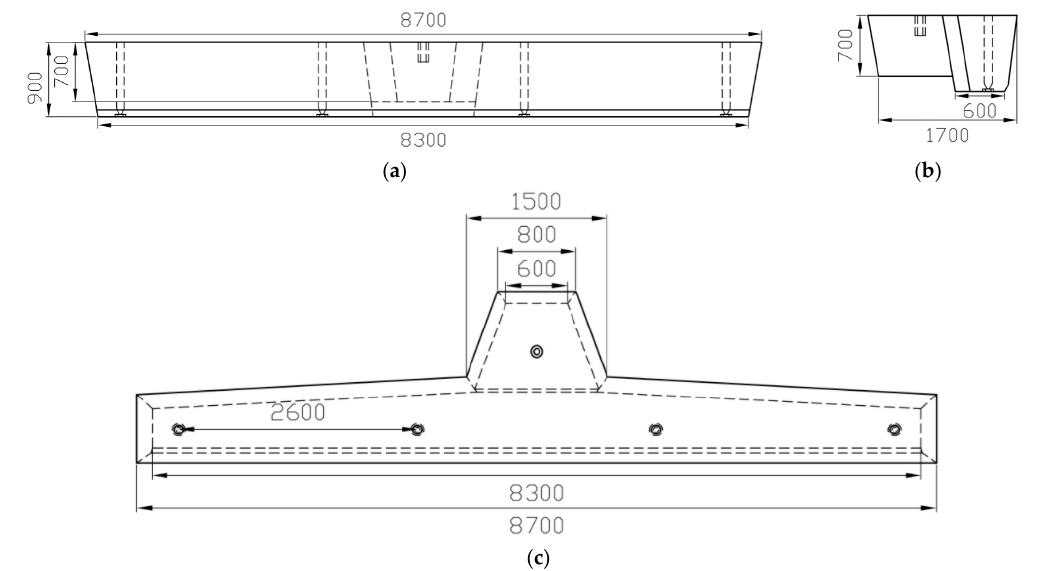
Figure 1. Approximate T-shaped tundish geometric structure size (mm). ( a ) Front view; ( b ) left view; and ( c ) top view.